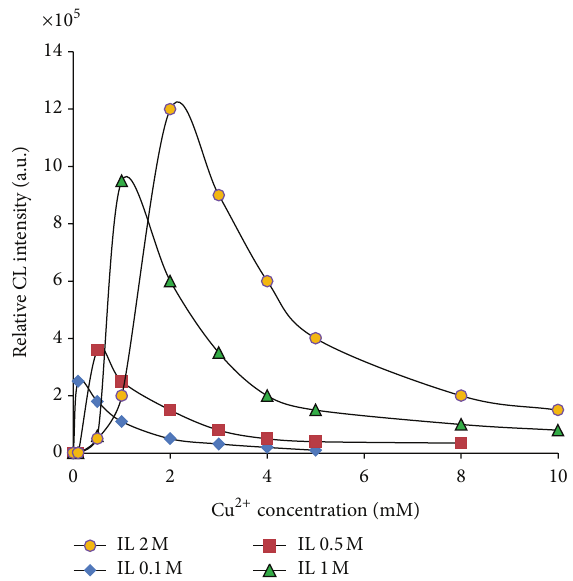
Figure 8: Light intensity as a function of different copper and IL concentrations in phosphate buffer (0.1M, pH 8.0); ZnS QDs, 20 mgL −1 , H 2 O 2 , and 0.5M.